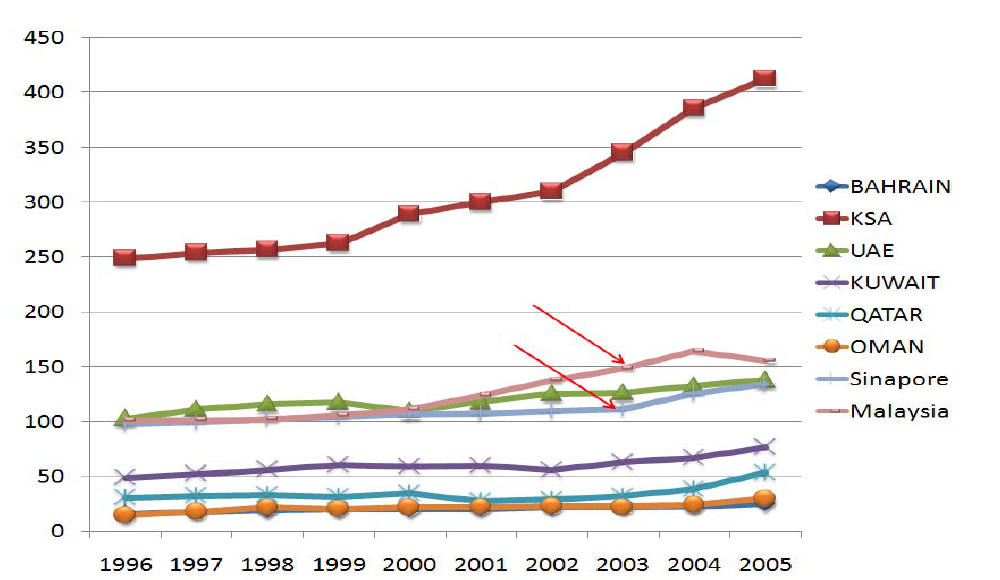
total emissions for GCC contraries, Malaysia and Figure 9. CO 2